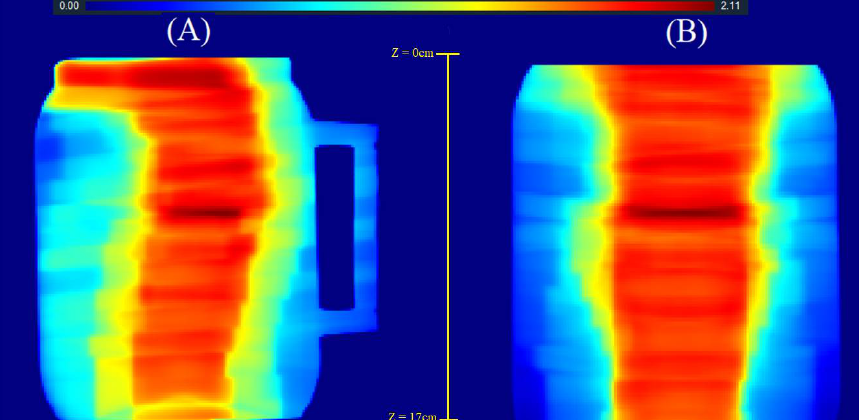
Figure 11. Complete dose distribution at the junction region of the treatment planning in the cylindrical vial geometry obtained by post-processing at Matlab ® 2016 with a different color map than CERR. The upper scale shows the dose range from 0 to 2.11 Gy. ( A ) Sagittal plane view. ( B ) Coronal plane view. An indication of the z-coordinate orientation of the slices is also presented.